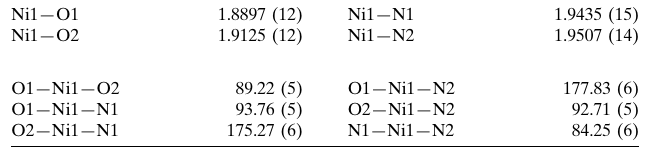
Selected geometric parameters (A˚ , (cid:1)